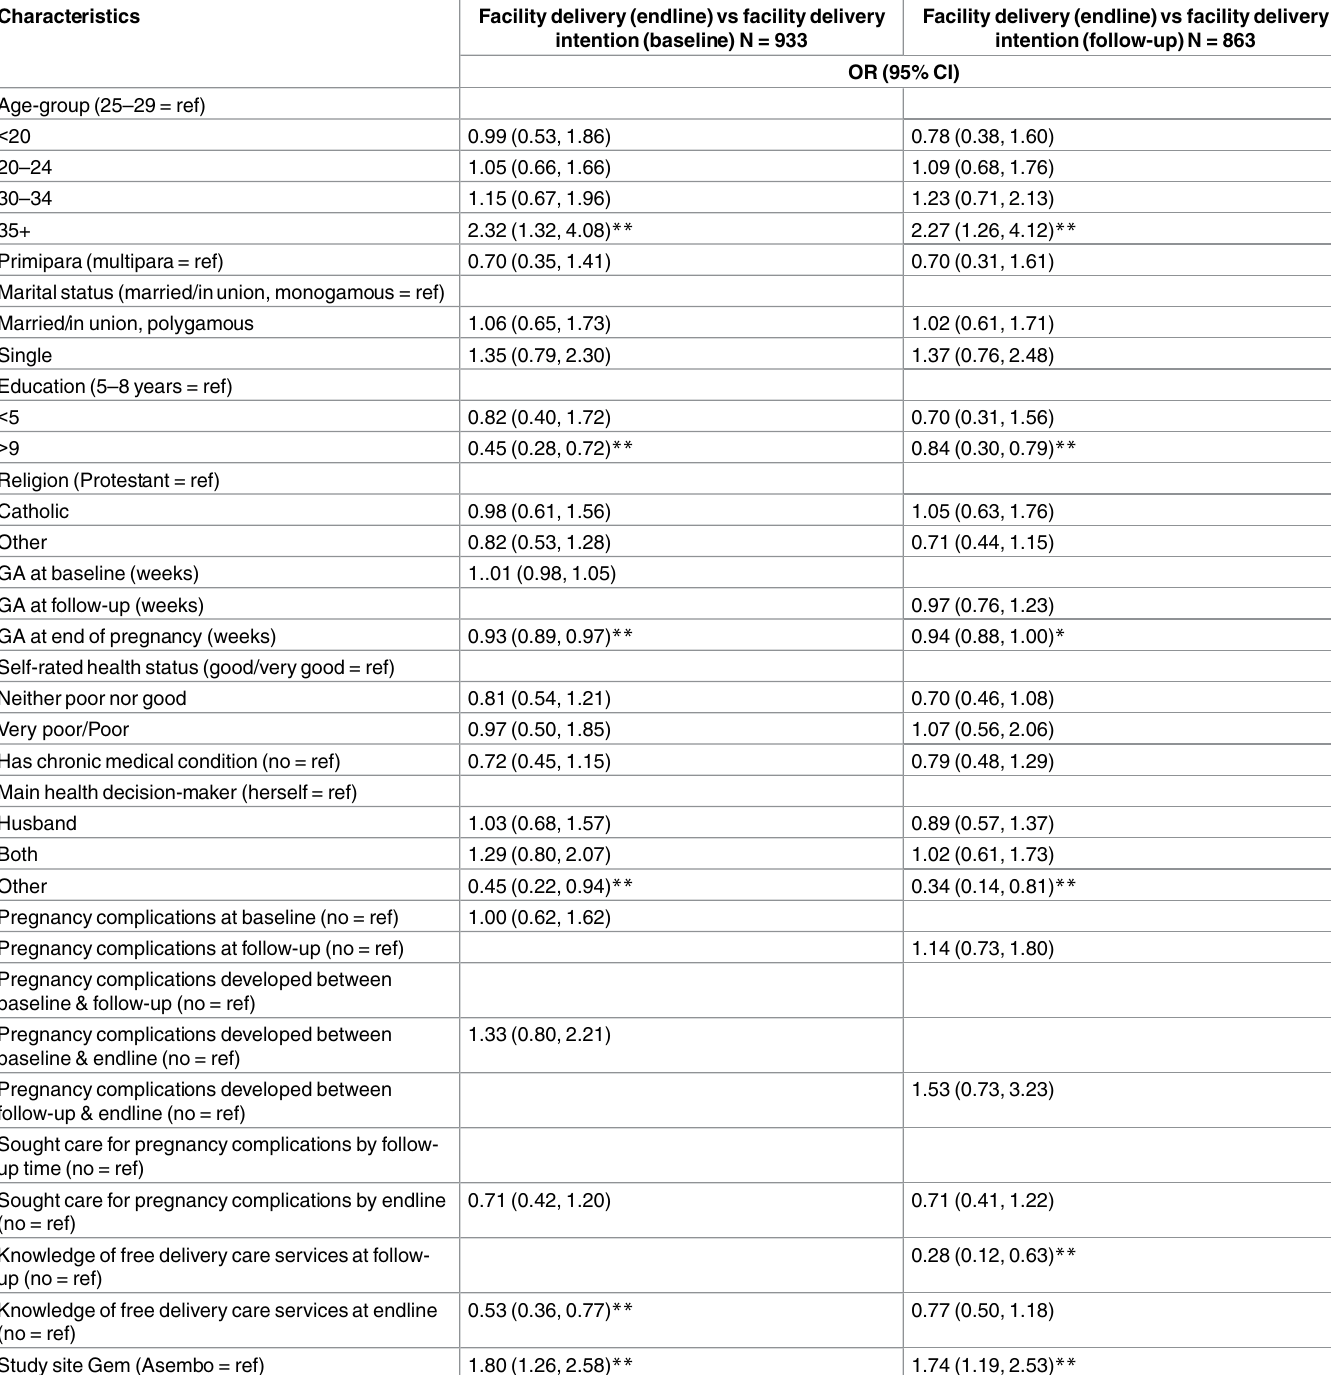
Table 2. Predictorsof discordance betweenwomen’s intentionsand behaviors regardingfacilitydelivery:Kenya, 2013.